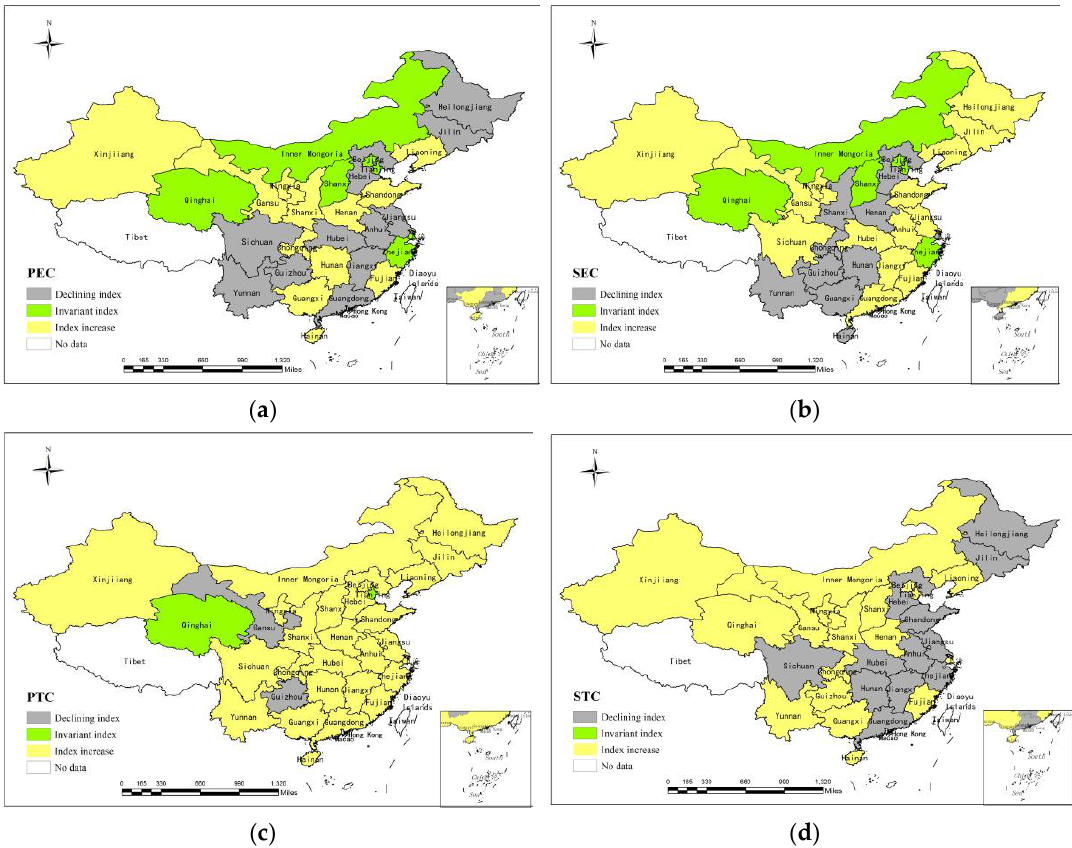
Figure 11. Spatial differentiation characteristics of water resource green efficiency index: ( a ) Spatial differentiation of pure technology efficiency change (PEC), ( b ) Spatial differentiation of scale efficiency change (SEC), ( c ) Spatial differentiation of pure technology change (PTC) and ( d ) Spatial differentiation of scale technology change (STC).